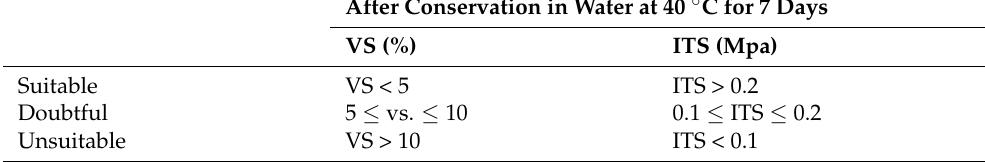
Table 2. Treated material sustainability